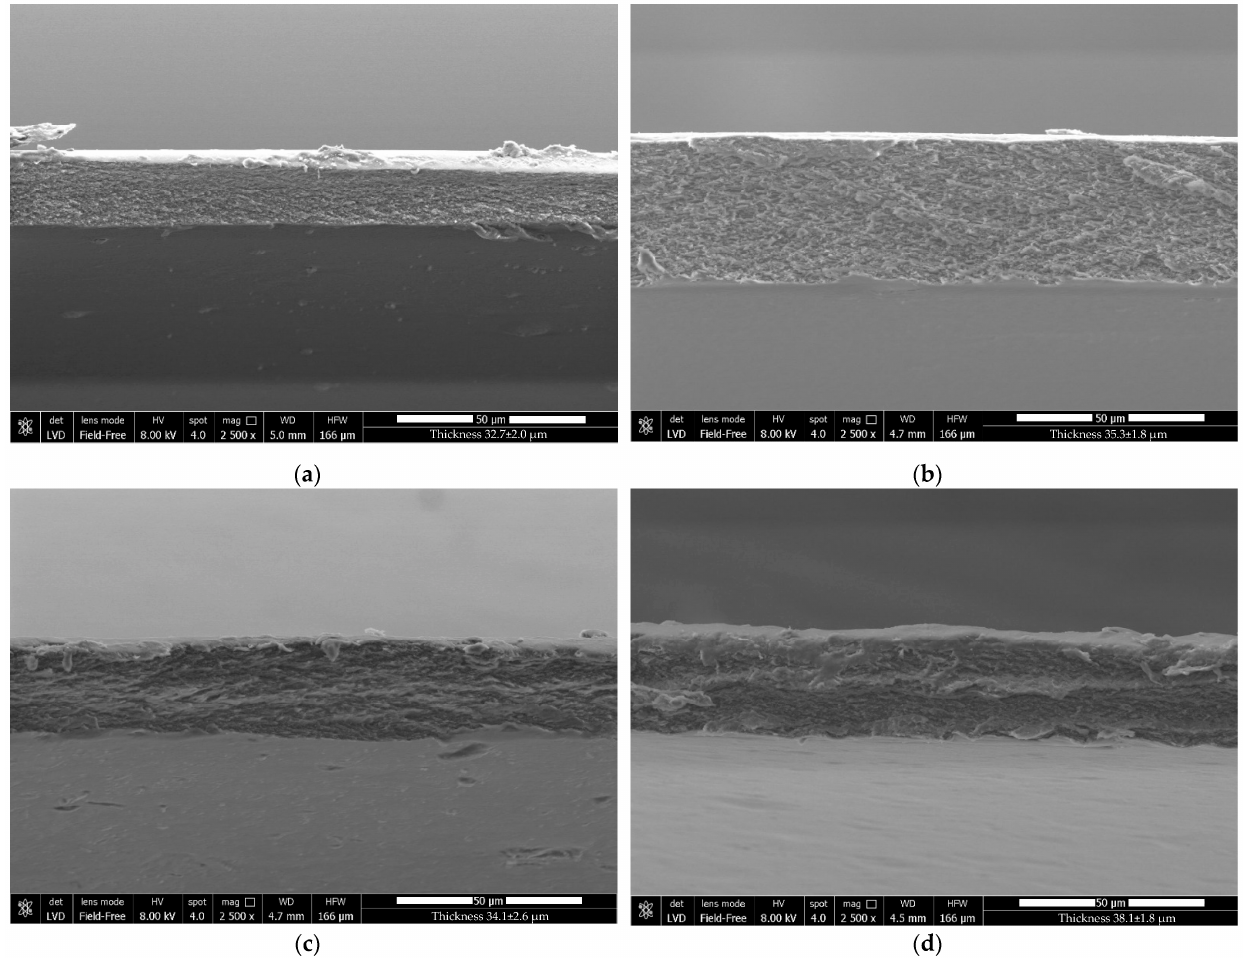
Figure 5. SEM images (cross-section) of films based on ( a ) chitosan/hydroxypropyl methylcellulose blend (CS/HPMC), ( b ) CS/HPMC/LAE, ( c ) CS/HPMC/CNCs, and ( d ) CS/HPMC/CNCs/LAE.